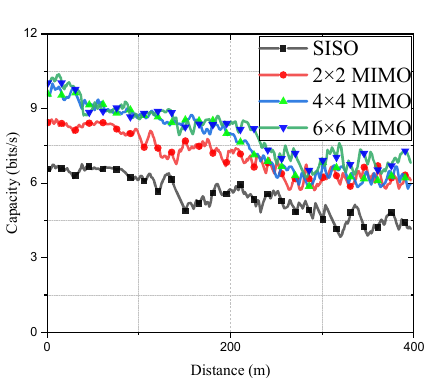
Fig. 5. Capacity versus distance between different MIMO systems.